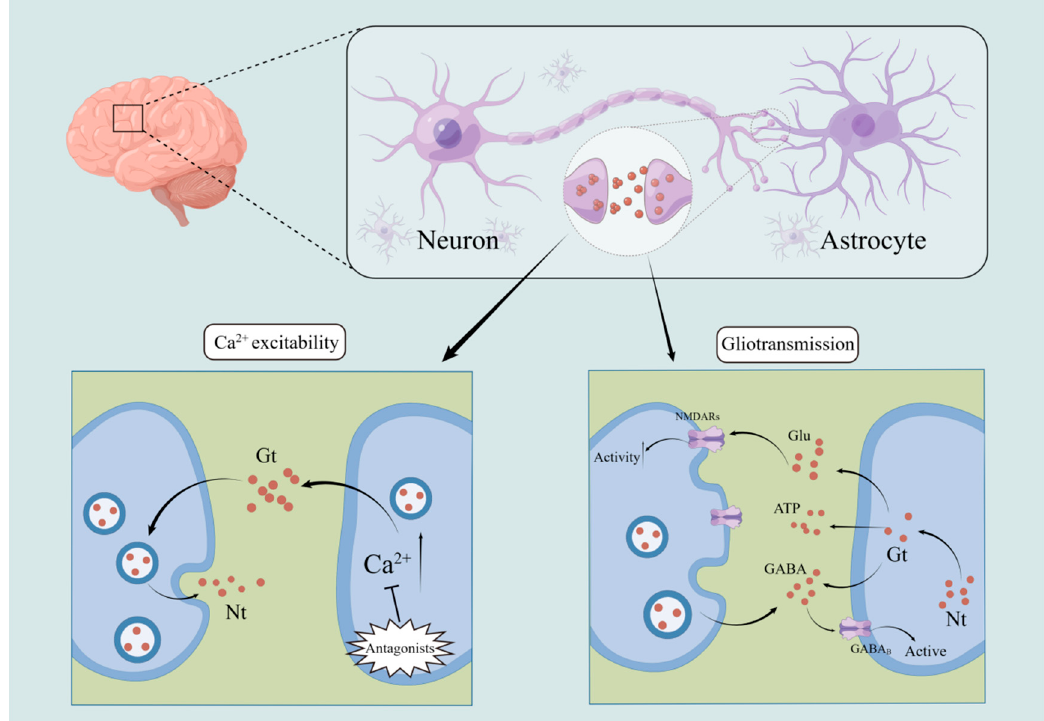
Figure 3. Astrocyte–neuron interactions. Increased Ca 2+ concentration in astrocytes causes neurons to respond, but this shift can be prevented by the use of ionotropic glutamate receptor antagonists. Depending on the type of receptor it binds, astrocytes can also affect synaptic transmission by releasing various gliotransmitters. At the same time, astrocytes can be activated via GABAB receptors by low-level stimulation of GABAergic interneurons.